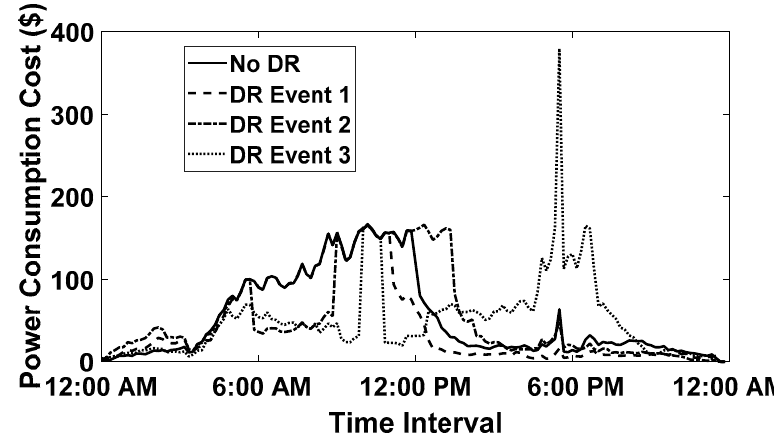
Figure 7. Power Consumption Cost comparison between DR Events.